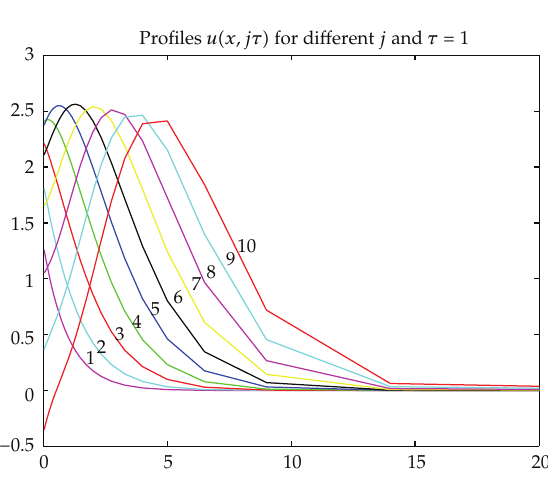
Figure 9: Example 5.1 by quasi-uniform